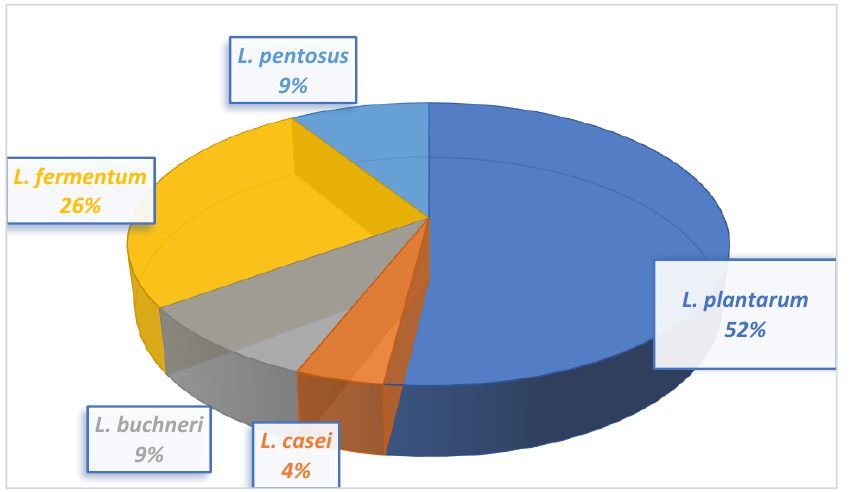
Figure 1. Occurrence of lactic acid bacteria isolates in milk samples. Lactobacillus plantarum was predominant among the lactic acid bacteria isolated from the milk